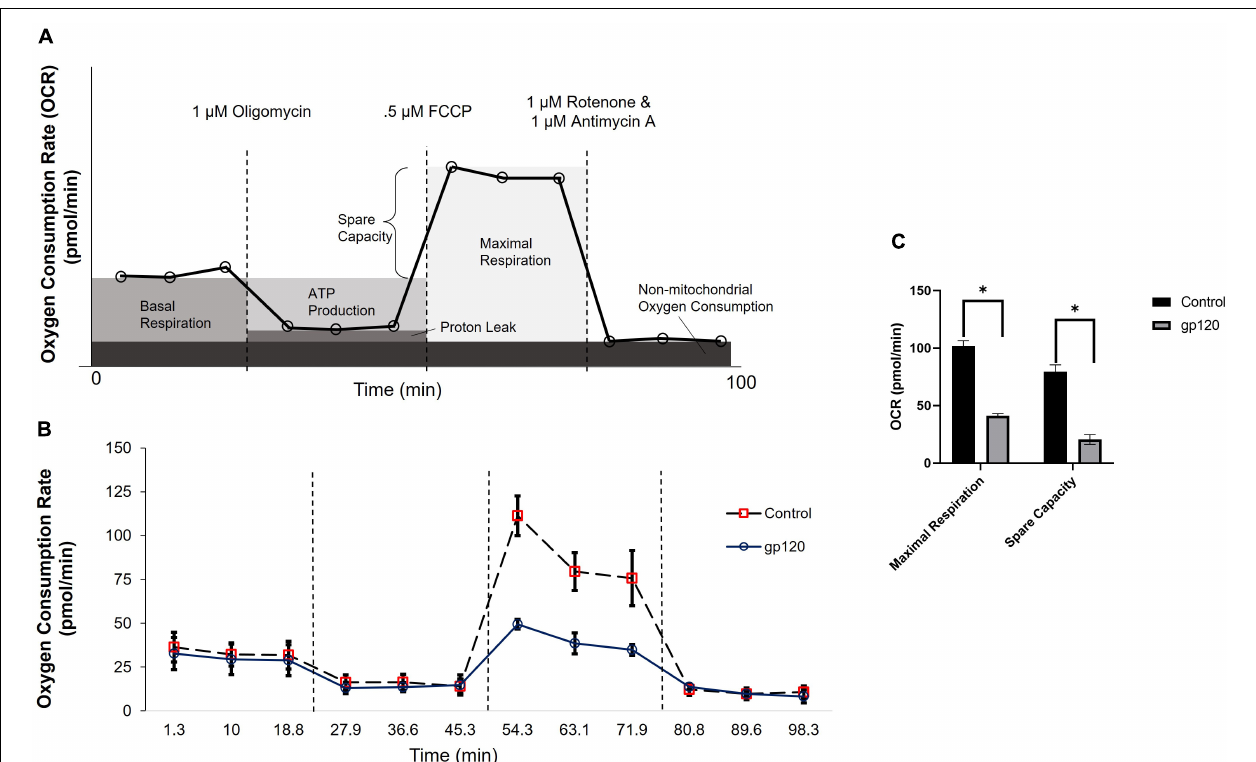
FIGURE 1 | gp120 alters mitochondrial maximal respiration. (A) A schematic of typical results from a Seahorse Mito Stress Test showing the interpretation of each measurement taken at different time points. (B) Measurement of oxygen consumption rate (OCR) in LUHMES cells untreated (dotted lane/red squares) or treated with 100 ng/ml of gp120 protein (solid lane/black circles) for 8 h using a Seahorse XFe96 analyzer and a Mito stress test kit from Seahorse. Oligomycin, FCCP, and rotenone/antimycin (dotted lines) were added at 23, 50, and 75 min, respectively. (C) Graph displaying the maximal respiration and spare capacity measured (pmol/min) in LUHMES untreated or treated with gp120. Values derived from the Seahorse analyzer and computed using Seahorse software were considered statistically significant ( ∗ p <